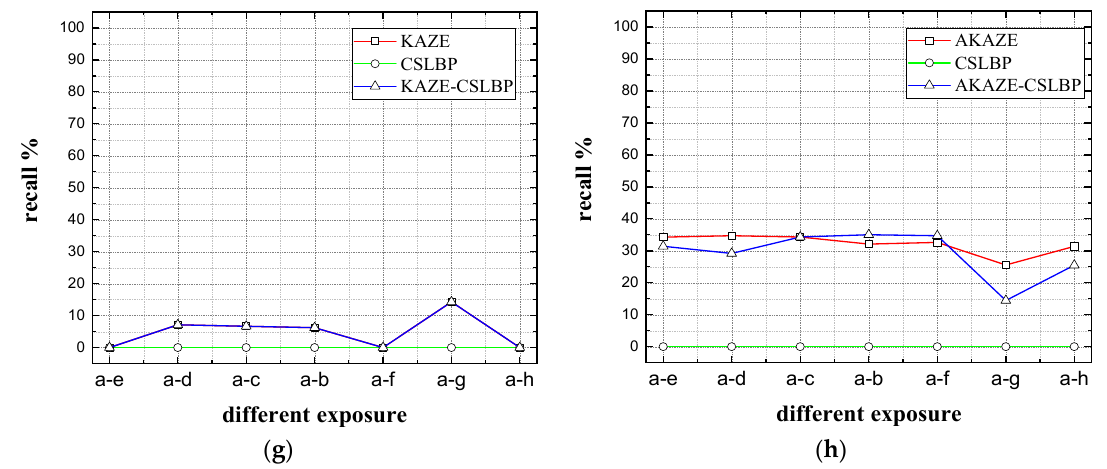
Figure 15. Matching results of the recall of Gra ffi ti sequence for the eight original, the CSLBP, and the combined descriptors. The X label represents the matched images of Gra ffi ti sequence, and the Y label denotes the recall for each descriptor. ( a ) SIFT features; ( b ) SURF features; ( c ) DAISY features; ( d ) BRISK features; ( e ) ORB features; ( f ) FREAK features; ( g ) KAZE features; and ( h ) AKAZE features.